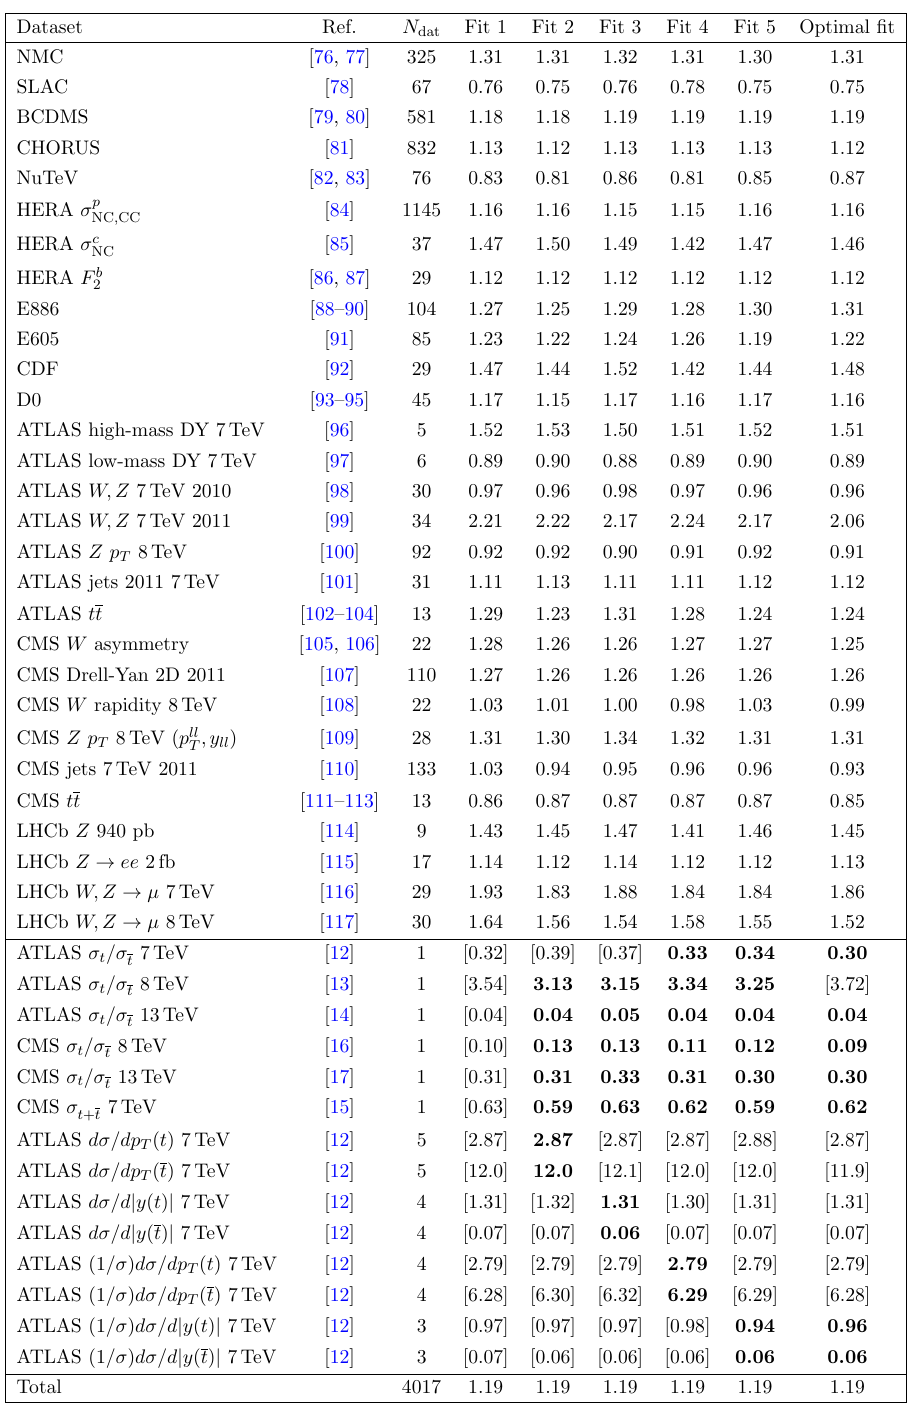
Table 6 . The (cid:31) 2 for the NNLO PDF (cid:12)ts summarised in table 5, as well as for the PDF (cid:12)t to the combination of data that we (cid:12)nd to be optimal. Numbers in boldface denote the single top measurements included in each (cid:12)t. Numbers in square brackets denote datasets not included in the (cid:12)t, and are computed from each